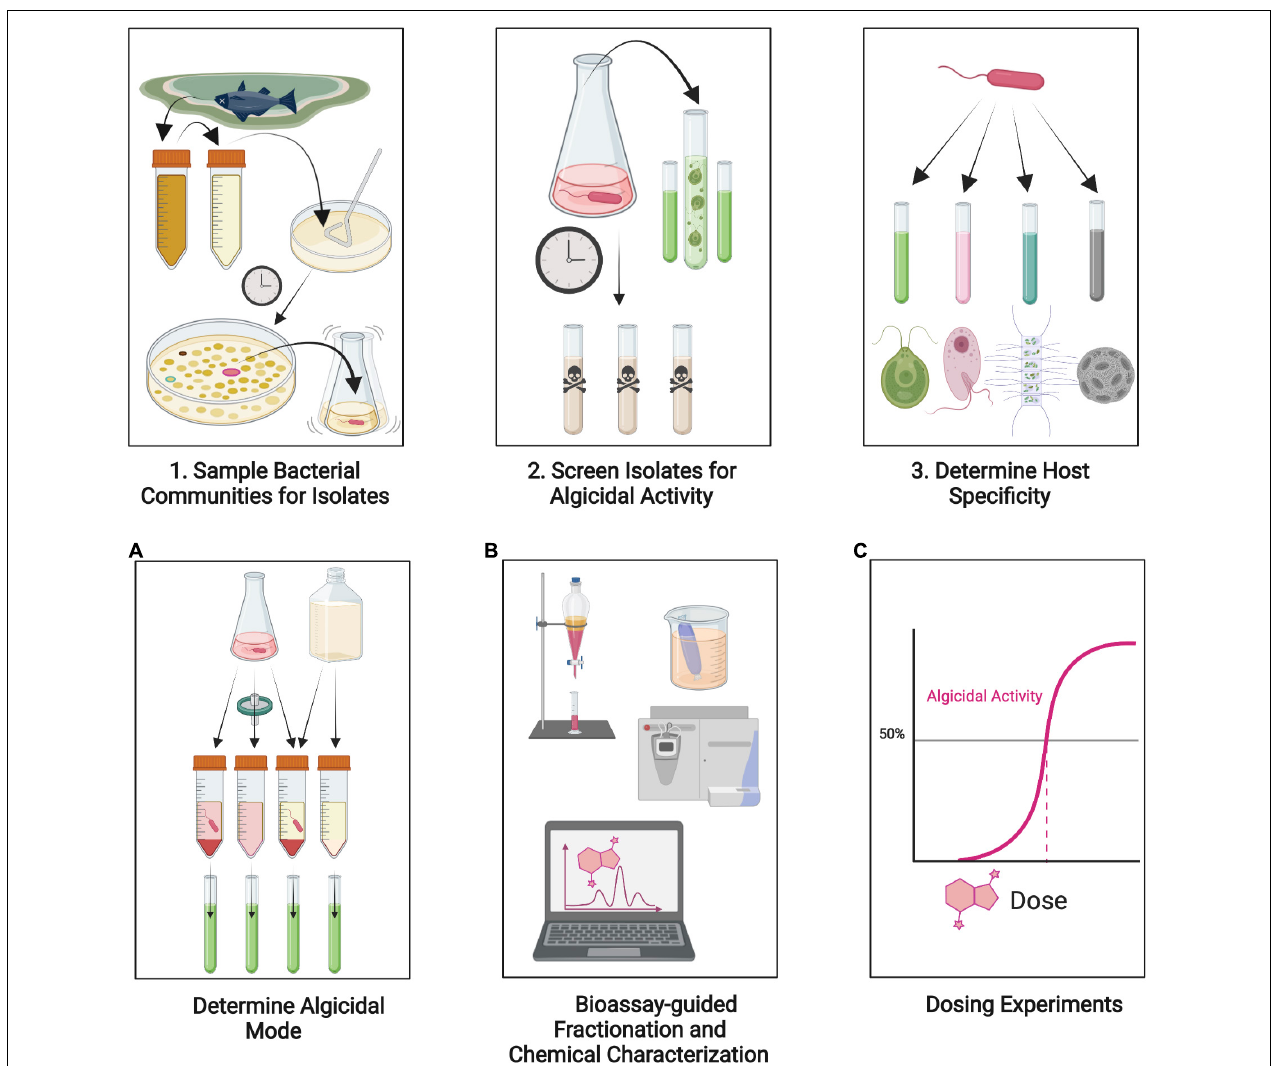
FIGURE 4 | Illustration of methodological conventions for discovery and description of a new algicidal interactions. See text for details. (1) Isolate bacteria co-occurring with algae in natural blooms or in culture. Note that our knowledge of algicidal interactions is biased toward bacteria that can be cultured. (2) Conduct bioassays of isolated bacteria to screen for algicidal activity. (3) Determine host specificity and range by testing on multiple species of algae. (A) Determine algicidal mode by comparing activities of bacterial cell culture, cell-free culture filtrate, and washed bacterial cells. (B) Characterize chemicals responsible for algicidal activity. This commonly involves a bioassay-guided fractionation by solubility or polarity or by size. Further chemical characterizations may be undertaken if activity is narrowed to a fraction. The structure of compounds can be elucidated by spectroscopic methods and/or mass spectrometry. (C) Test the algicidal compound(s) to identify effective concentrations. Created with